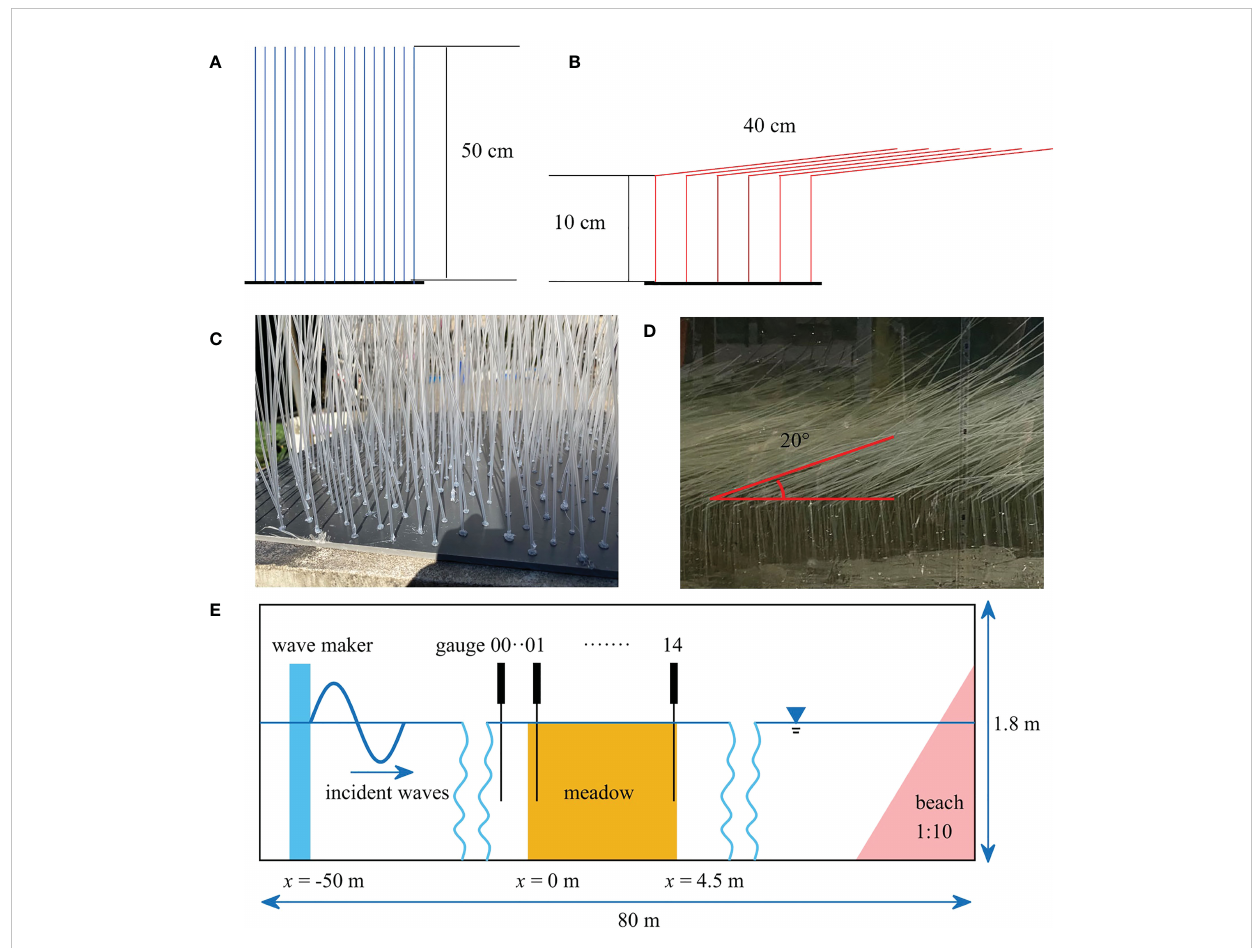
FIGURE 2 Sketches of (A) standing and (B) fl attened vegetation. Photos of the (C) standing and (D) fl atten model vegetation in the fl ume. (E) Experimental setup for measuring the wave attenuation by vegetation (dimensions are not